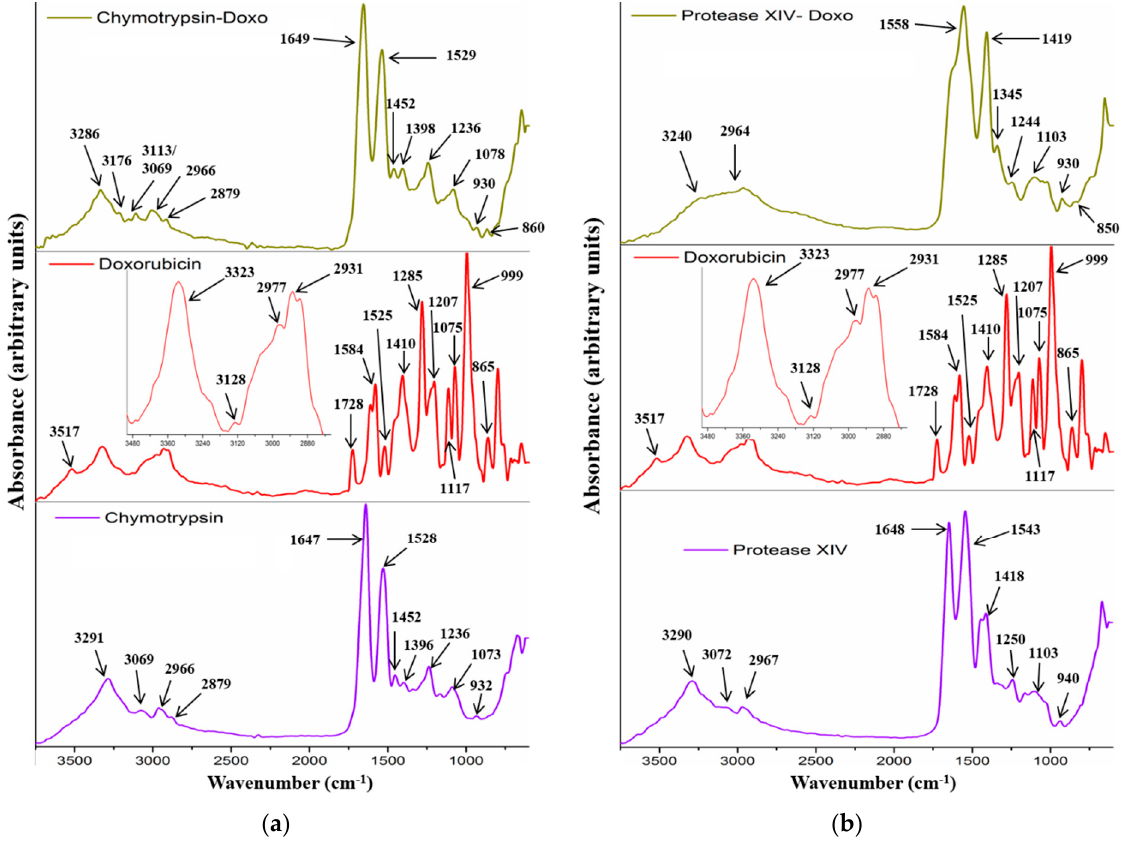
Figure 2. FTIR–ATR spectra of enzymes (protease IV and chymotrypsin), doxorubicin, and association of chymotrypsin/doxorubicin ( a ) and protease IV/doxorubicin ( b ).